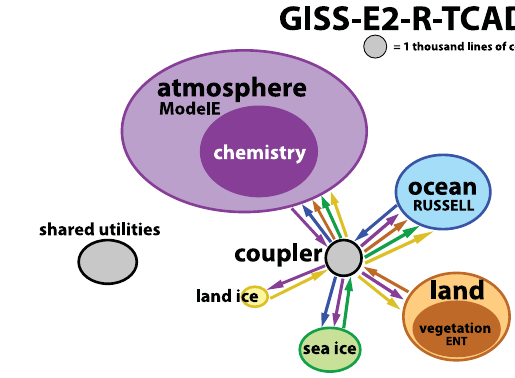
Figure 1. Architecture diagram for CESM1-BGC.